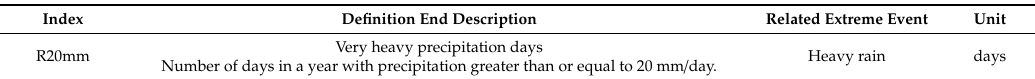
Table 1. Relevant extreme climate indices selected for heavy rain, flooding, drought, and extreme